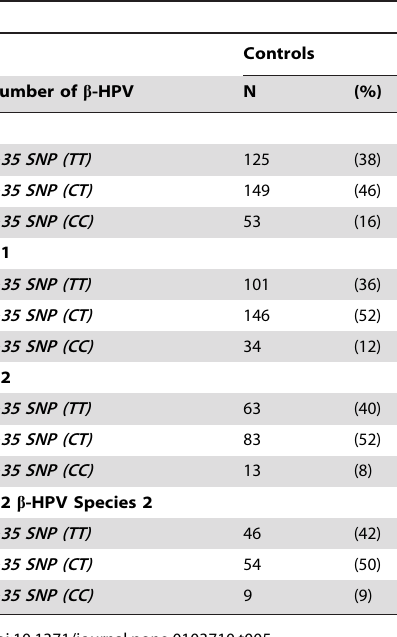
Table 5. Association of 2 35 kb SNP with case status, stratified by b -HPV.